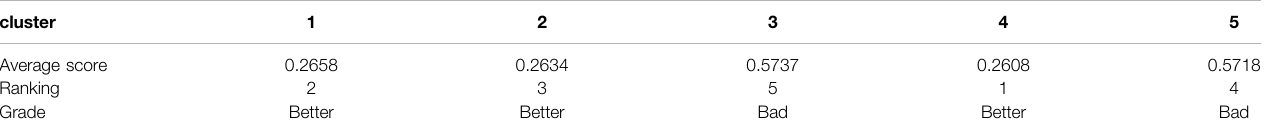
TABLE 3 | Average score of the 5 water quality clusters.